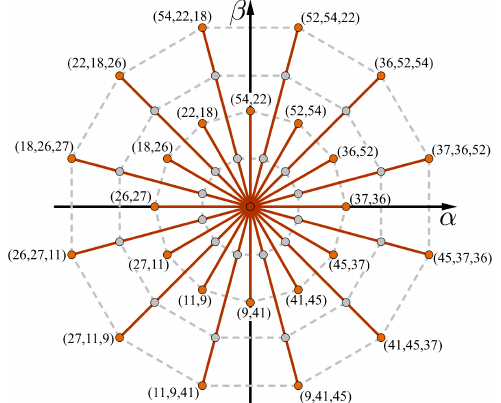
Figure 4. Selection of the voltage vectors in the modulation stage in